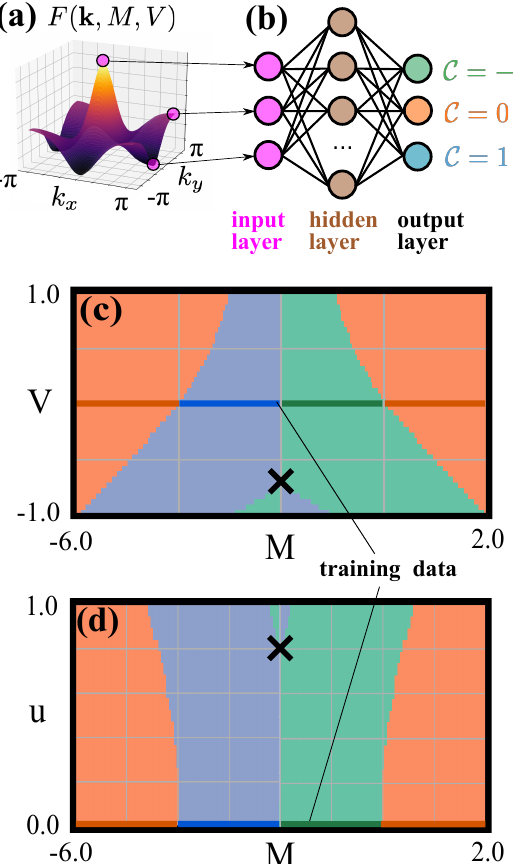
Figure 2: Machine learning scheme to classify different topological phases in inter- acting 2D Chern insulators. (a) The curvature function at zero frequency ω = 0 and = ( 0,0 ) , ( 0, π ) , ( π , π ) used as input the three inequivalent high-symmetry points k 0 data for the neural network – whose architecture is depicted in (b). The ML predicted topological phase diagram for the interacting Chern insulators: (c) electron-electron interactions and (d) electron-phonon interactions. In both cases, the neural network is trained with noninteracting data (shaded lines at V = 0 in c) and d)), correspond- ing to the three inequivalent topological phases with C = 0, ± 1. The method unveils the existence of multicritical points between the C = 1 and C = − 1 phases, indicated by the black